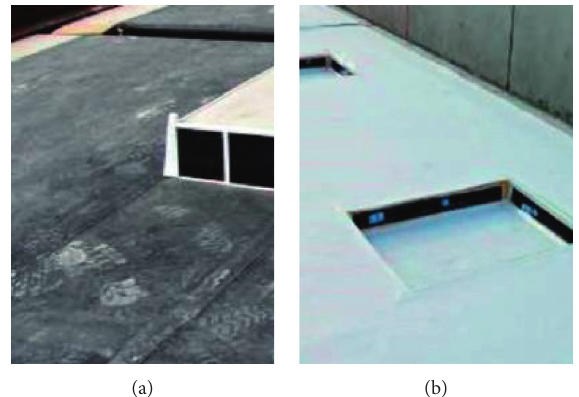
Figure 2: Commonly used isolation layers: (a) EPDM isolation layer; (b) geotextile isolation layer.